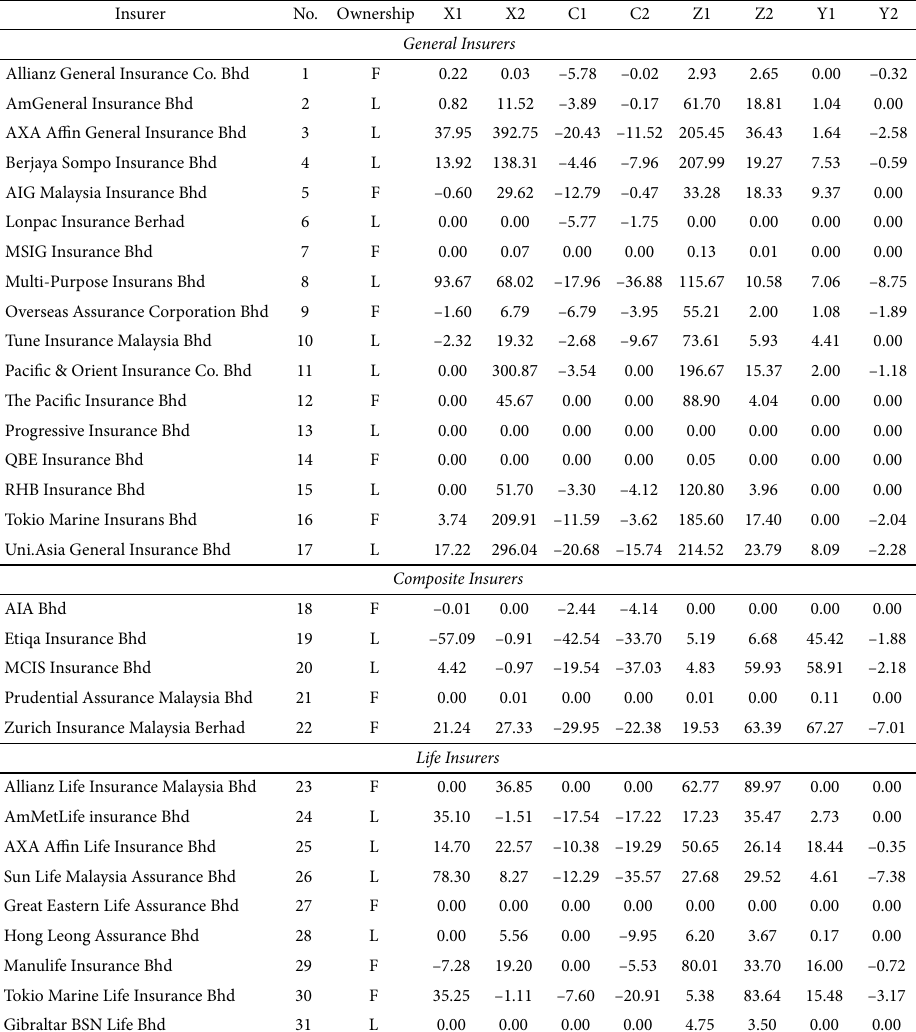
Table A2. Frontier projections – potential areas for improvement,